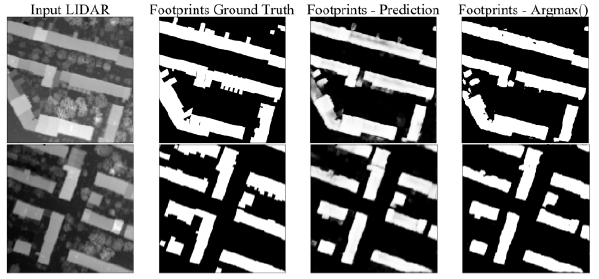
Figure 12. Semantic segmentation network prediction using model b5_2_512 in Table 1. The binary conversion process is expressed in the figure as Argmax().